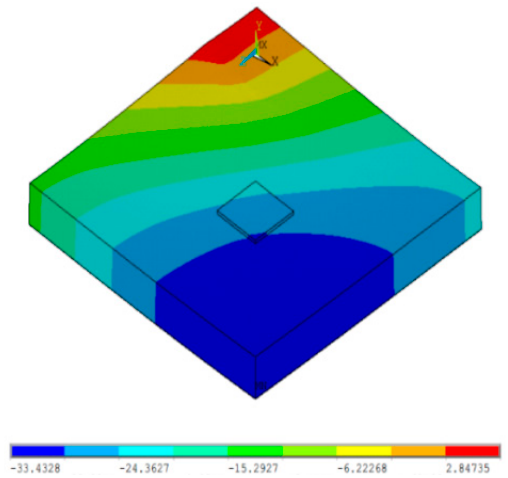
Figure 17. Deformation shape of BS2 slab.